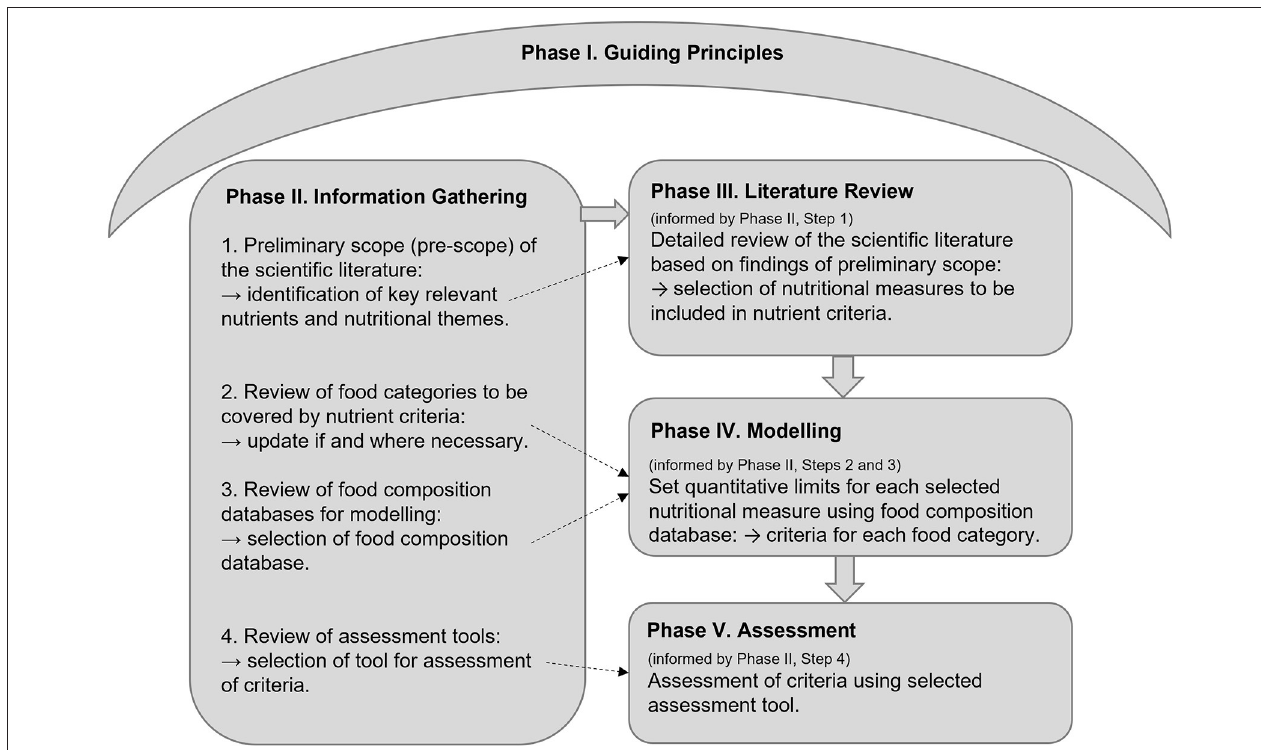
FIGURE 1 | Summary of the nutrient criteria methodology: The five Phases. Phase I, the development of guiding principles to underpin decision-making in each subsequent phase. Phase II, information is collected to inform subsequent phases by conducting: (1) Pre-scope of the scientific literature to inform Phase III; (2) Update of food categories covered by the nutrient criteria to inform Phase IV (if applicable); (3) Review of food composition databases to inform Phase IV; and (4) Review of nutritional quality assessment tools for the updated criteria to inform Phase V. Phase III, literature review of all possible nutrients relevant to the nutrient criteria to inform nutrient selection in the criteria. Phase IV, food modeling to set quantitative limits for each selected nutrient, by food category. Phase V, assessment of the criteria against an established nutritional quality assessment